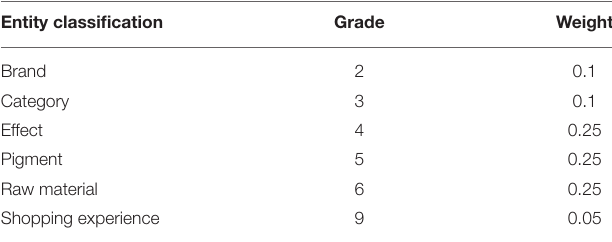
TABLE 3 | Cosmetic class weight system